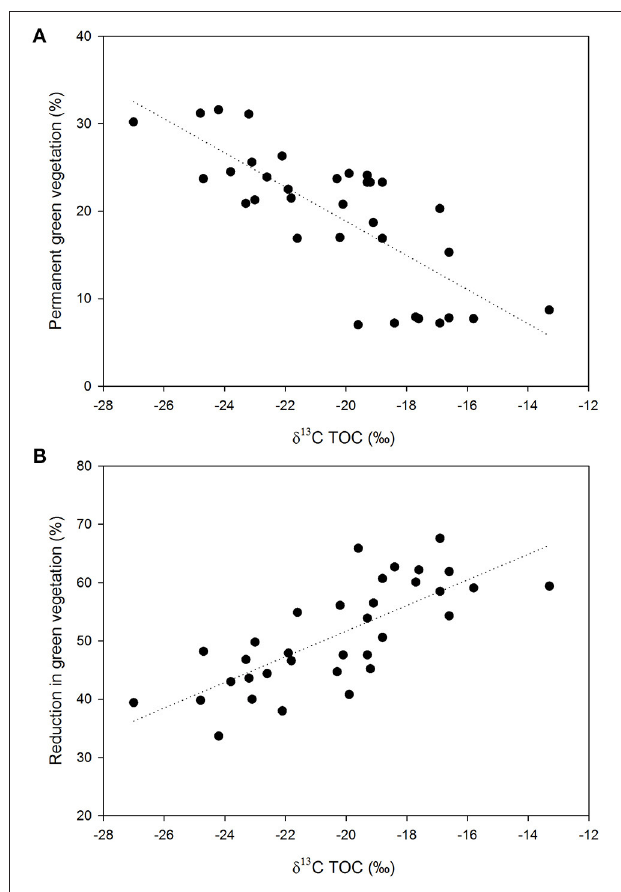
FIGURE 2 | (A) Relationship between the stable carbon isotope composition of sediment samples and the proportion of vegetation remaining green throughout the year (perennial biomass photosynthetically active) at each micro-basin; (B) Relationship between the stable carbon isotope composition of sediment samples and the relative reduction in green vegetation between the wet and the dry seasons. Regression coefficients ( r 2 ) are 0.60 and 62 for (A,B) respectively; p < 0.05 in both regressions. Land cover data is derived from VegMachine ® (Karfs et al., 2004), a software tool that summarizes decades of Landsat satellite imagery processed and compiled by the Remote Sensing Centre, Queensland Department of Science, Information Technology and Innovation